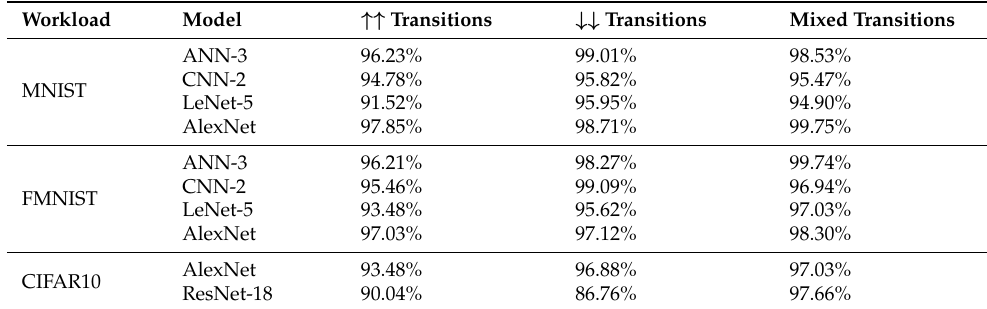
Table 5. Fault coverage in the presence of double faults.